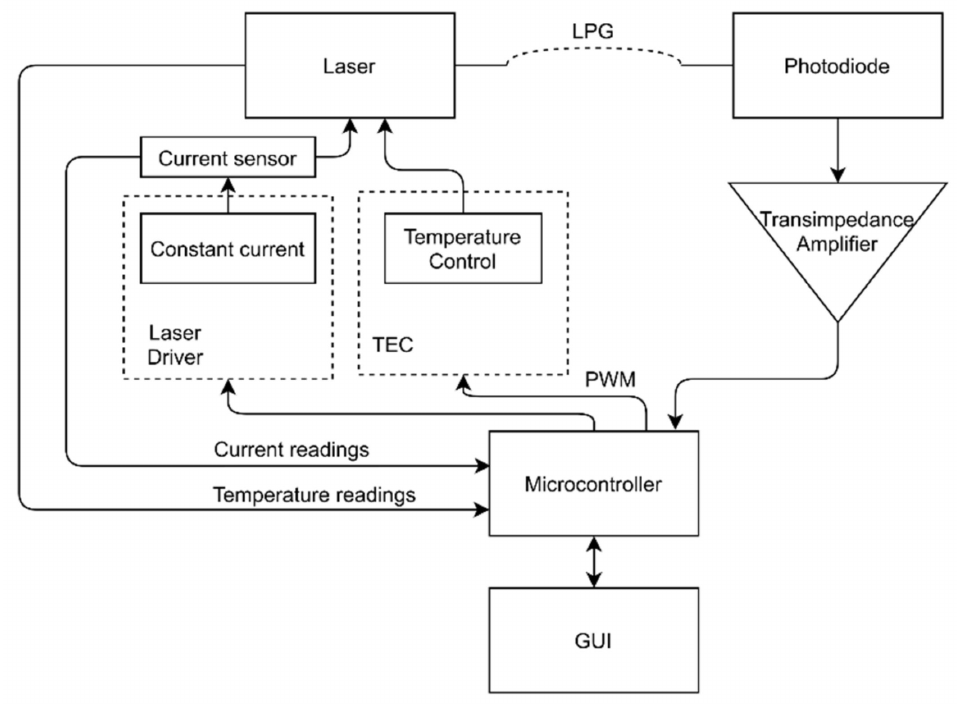
Figure 3. Block diagram of the developed interrogation